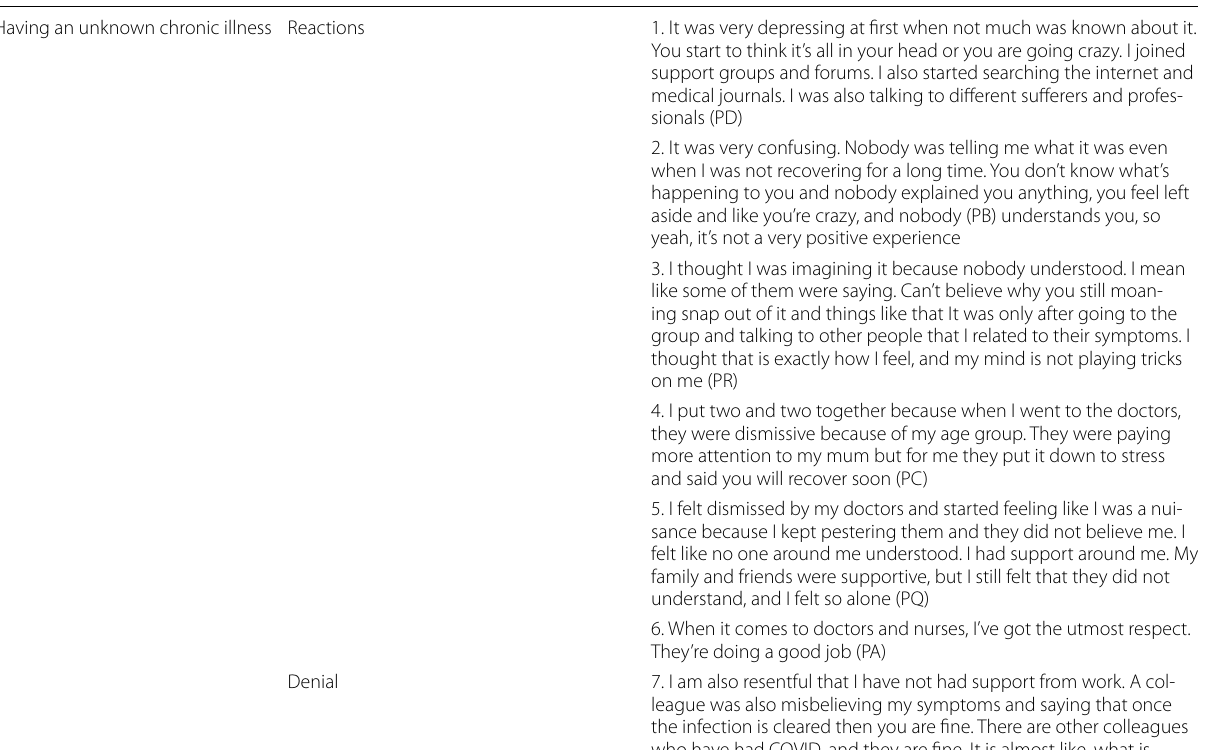
Table 3 Emerging themes and subthemes with illustrative quotes Theme Subtheme Quotations Having an unknown chronic illness